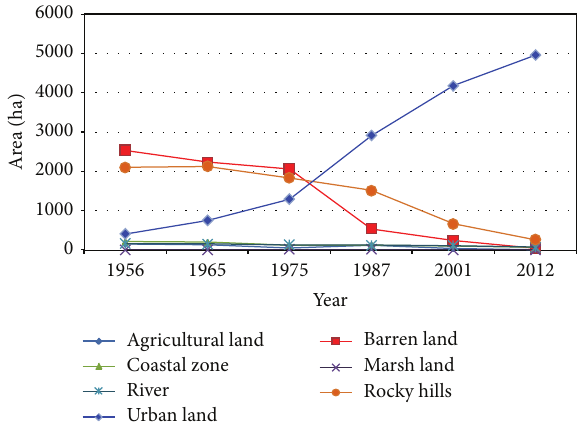
Figure 7: Land use changes in Bandar Abbas city